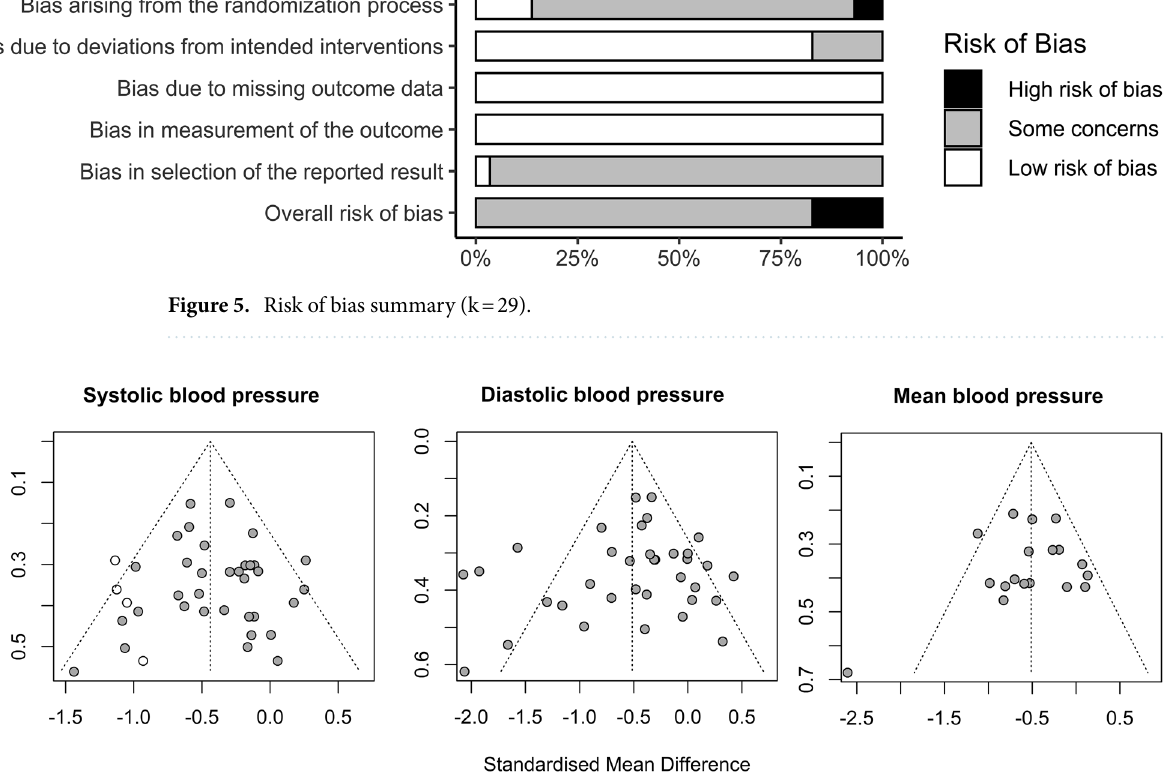
Figure 6. Publication bias representation by trim and fill funnel plots. White circles represent possible omitted studies.